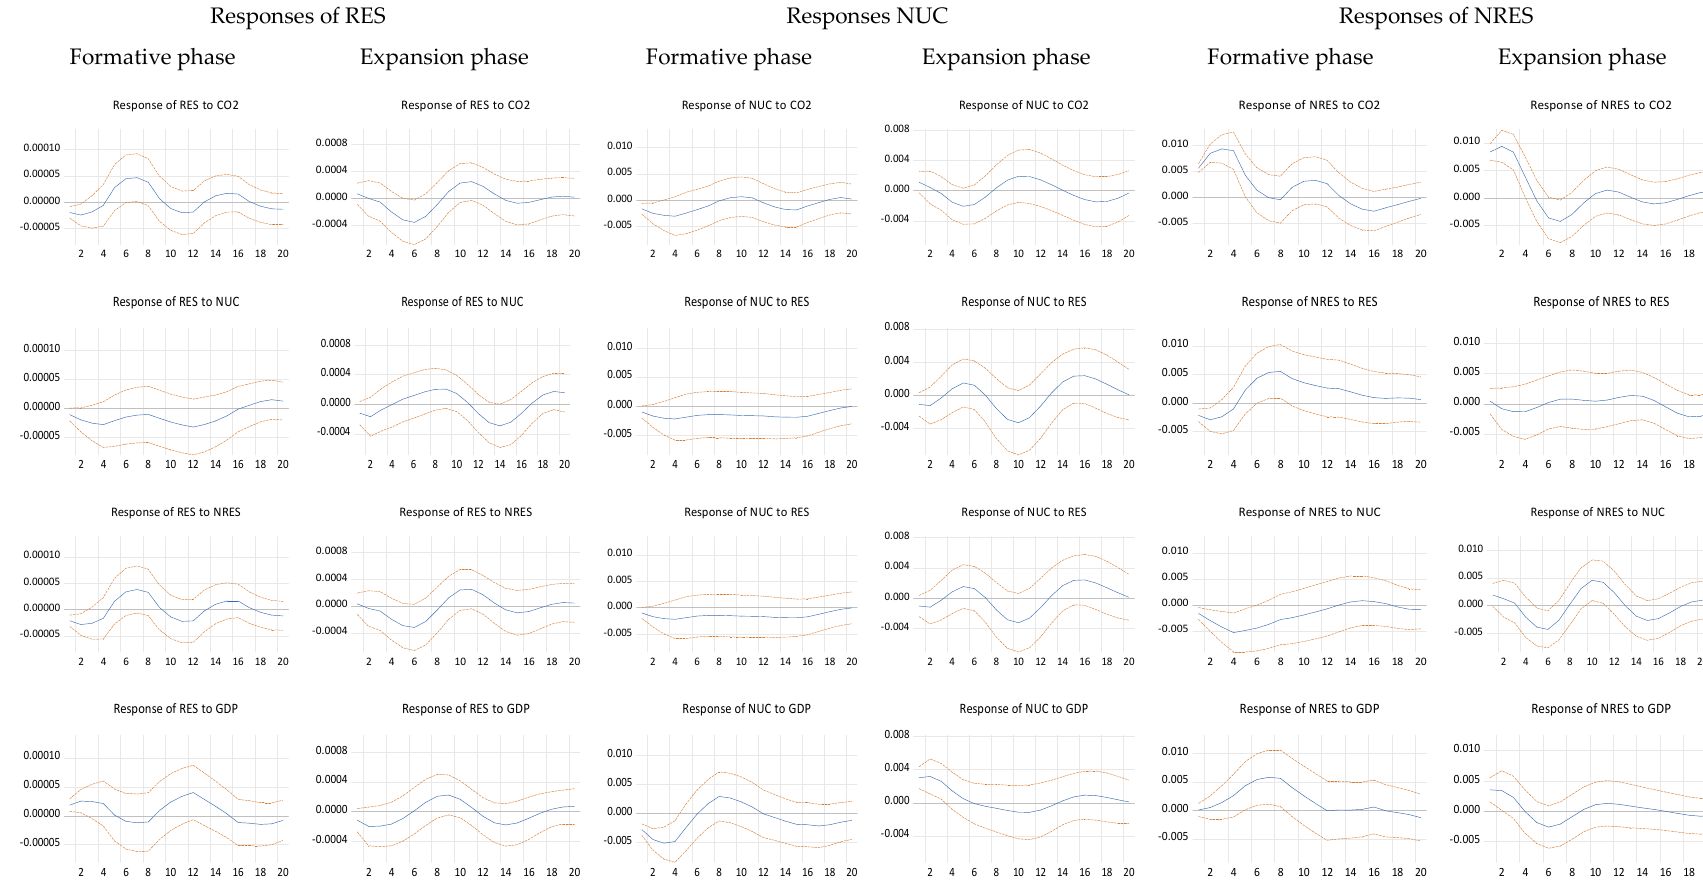
Figure A1. Responses of RES, NUC, and NRES to shocks in variables in the formative and expansion phases in France.